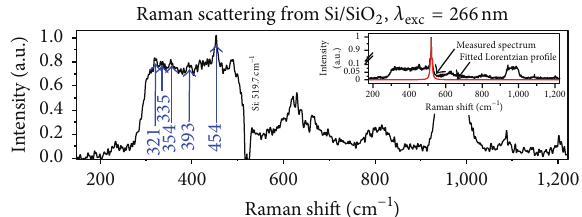
Figure 3: Raman spectrum of silicon dioxide layer placed on silicon substrate after removal of one-phonon Si line. Maxima of narrow lines assigned to crystalline forms of silicon dioxide are given in the main plot (blue numbers). The maximum of one-phonon Si line is also given in main plot (black number). The inset presets the spectrum before removal of one-phonon Si line (black) and Lorentzian function used for reconstruction of silicon line